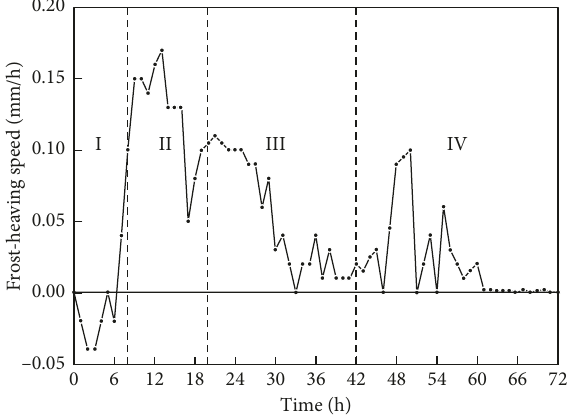
Figure 9: Variation of frost heave speed with